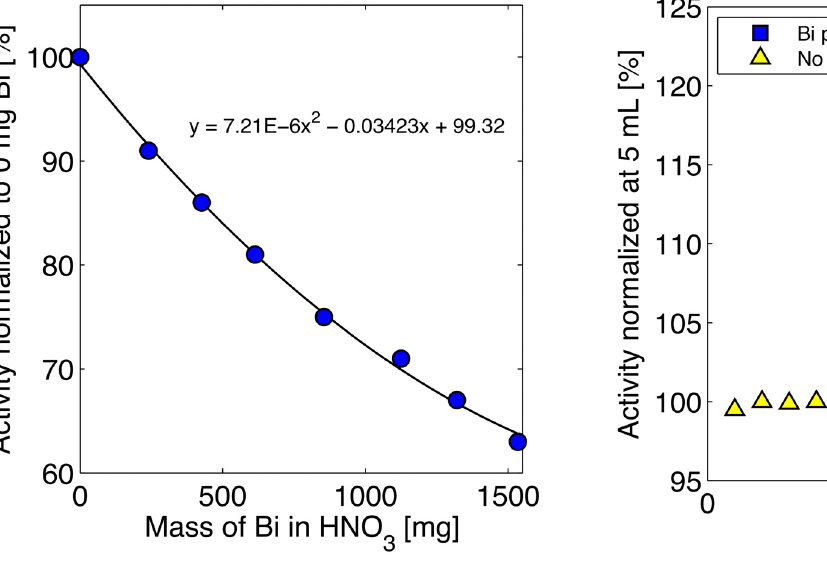
; ( B ) Dependence of sample 3